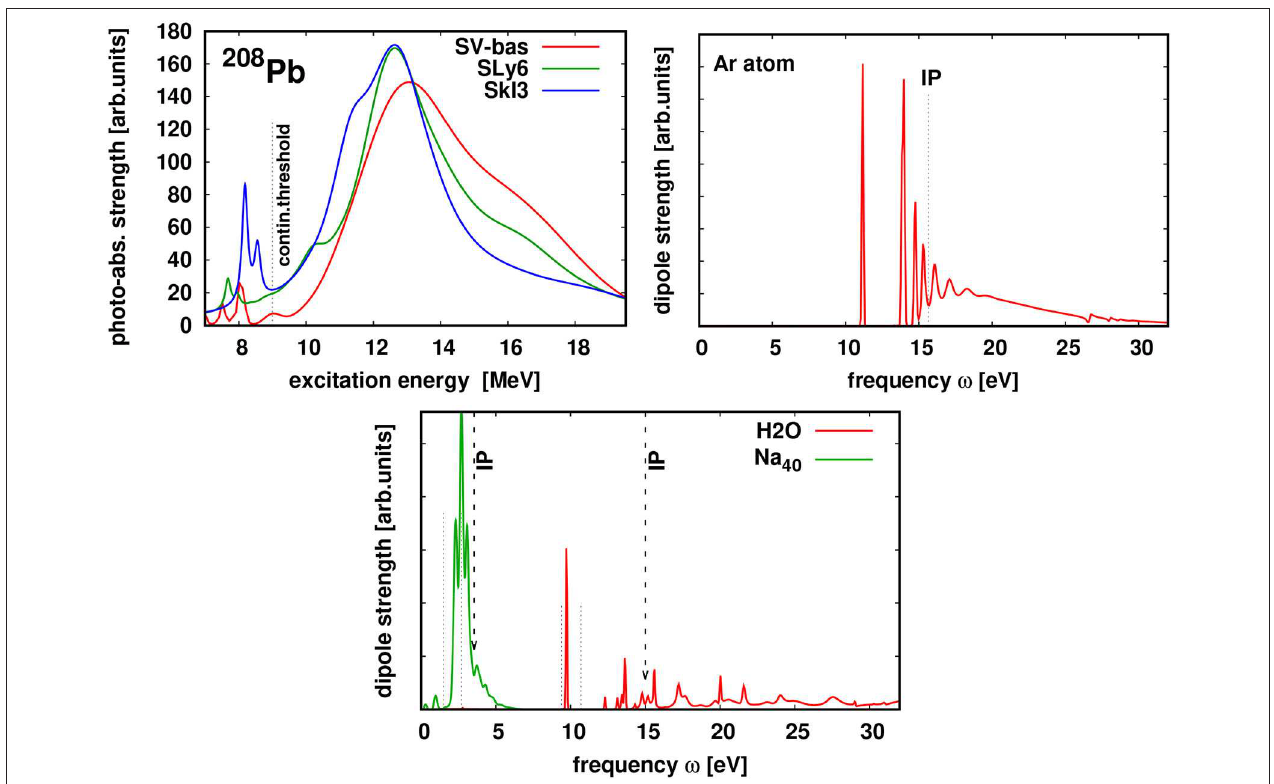
FIGURE 2 | Optical absorption spectra for three electronic systems as indicated and the nucleus 208 Pb. The electronic systems are computed with TDLDA + ADSIC as explained in section 2. The nucleus is computed with nuclear TDHF using the code of [37] (for details see Reinhard et al. [50]) and three different Skyrme parameterizations as indicated, SkI3 from [ 51], SLy6 from [52], and SV-bas from [53]. The vertical dashed lines indicate the particle continuum thresholds in each system, the electronic ionization potential (IP) and the neutron threshold in the nuclear